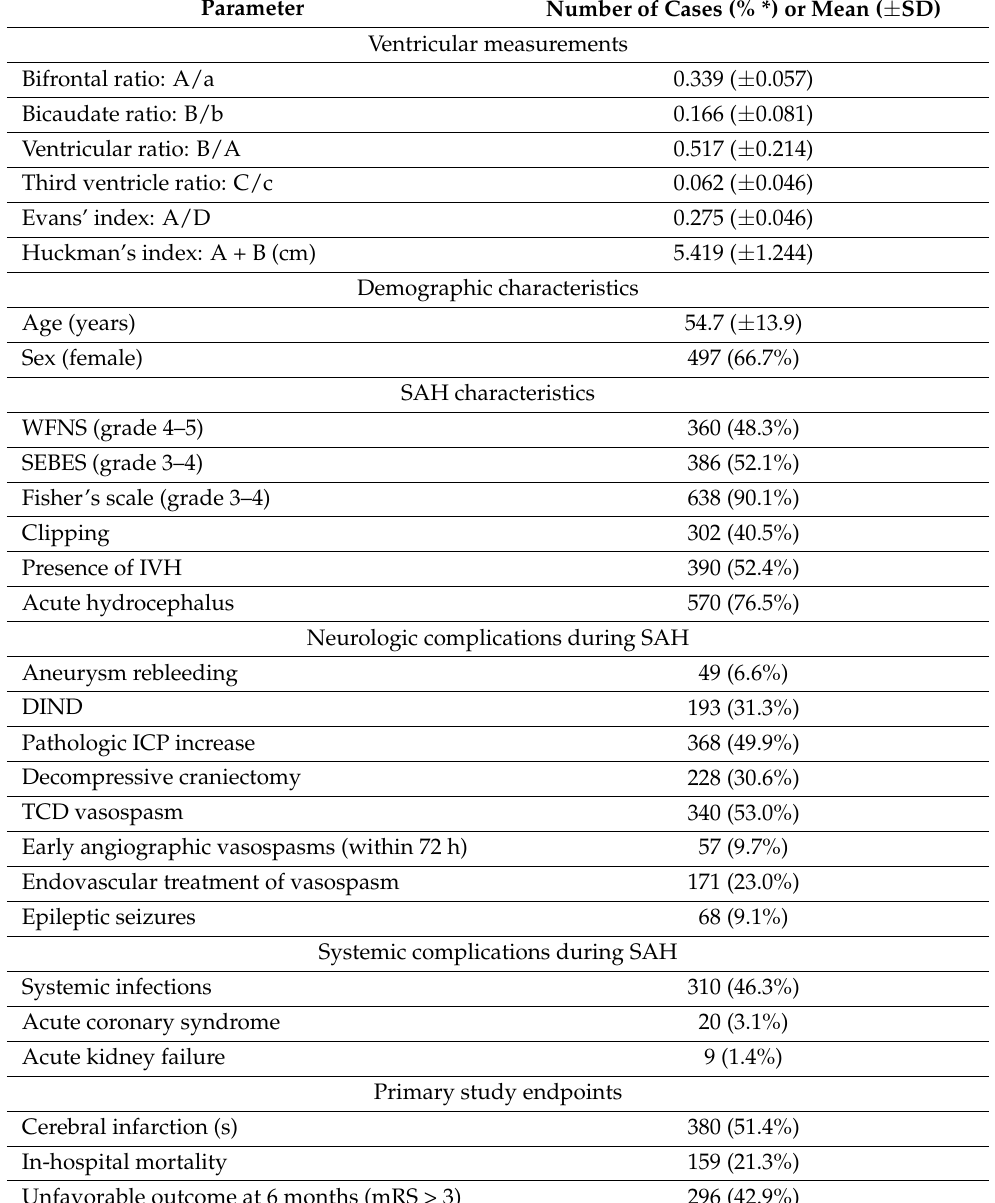
Table 1. Major demographic, clinical and radiographic characteristics of the final